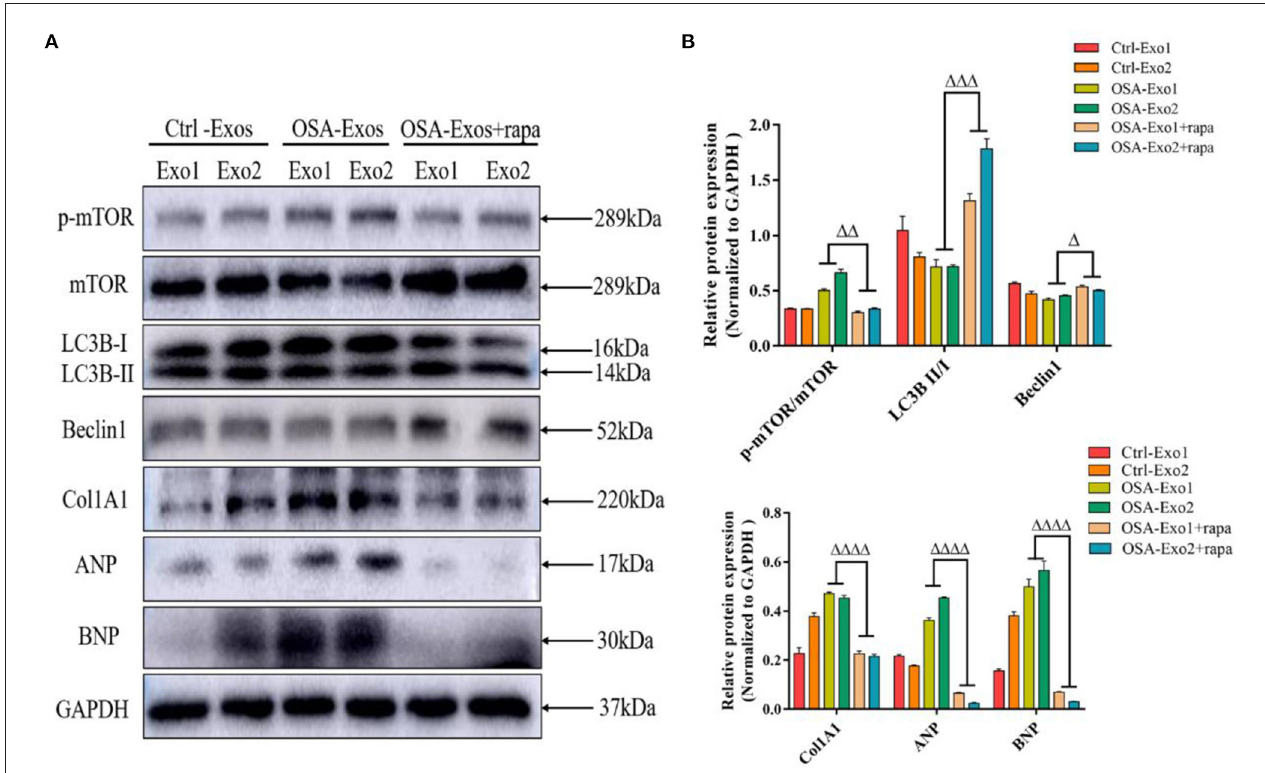
FIGURE 4 | Akt/mTOR-mediated autophagy was involved in OSA-Exos induced cardiomyocyte damage. (A) Rapamycin treatment significantly decreased the increased p-mTOR/mTOR, Col1A1, ANP, and BNP protein expression and increased the decreased LC3B II/I and beclin1 expression induced by OSA-Exos treatment. (B) Densitometric analyses of the Western blot presented in A. GAPDH served as the internal control. The bars indicate the mean ± SD of three separate experiments. 1 p < 0.05, 11 p < 0.01, 111 p < 0.001, 1111 p < 0.0001 vs. OSA-Exos groups. rapa,